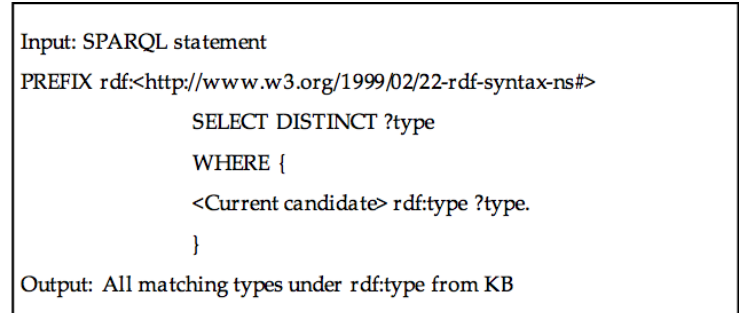
Figure 5. The SPARQL query used for generating candidate types.